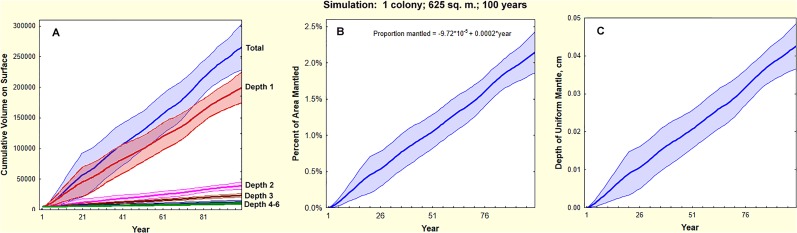
Simulation of mantling by one colony in an average territory over 100 years.A. The cumulative volume (cm3) of soil brought to the surface from increasing depth (only 5 of 6 depth categories are shown) and the total over one century. By far the most soil was brought up from the shallowest depth where the largest chambers are located. Regression equations for each depth category are given in Table 2, data in S7, S8 Tables. Each colony mantles the surface with about 200 L per century from depth 1, 35 L from depth 2, then decreasing to 5 L from depth 5. B. the cumulative proportion of the area covered by nest discs. By the end of a century, nest discs would have covered over 2% of the area, but wind, rain and animals would have spread these out much more uniformly. C. The depth of mantled soil if it were spread uniformly over the area. Approximately 0.35 to 0.5 cm accumulate per millennium, with a mean of about 0.43 cm.